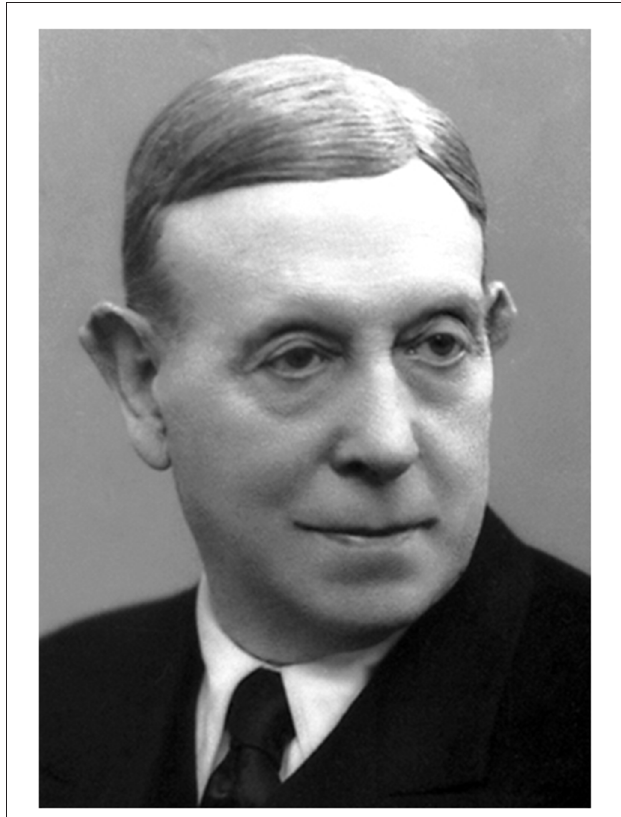
FIGURE 1 | A picture of Professor Antonio Caetano de Abreu Freire Egas Moniz. Kindly provided by the Library of the School of Medicine, University of